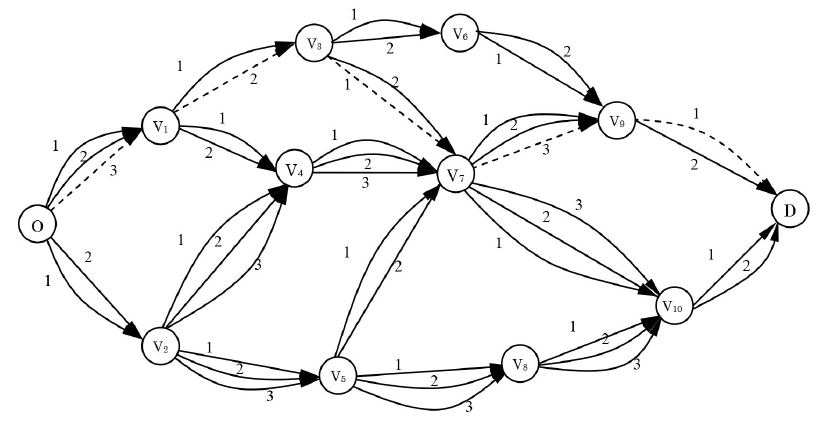
Figure 1. Directed graph with 12